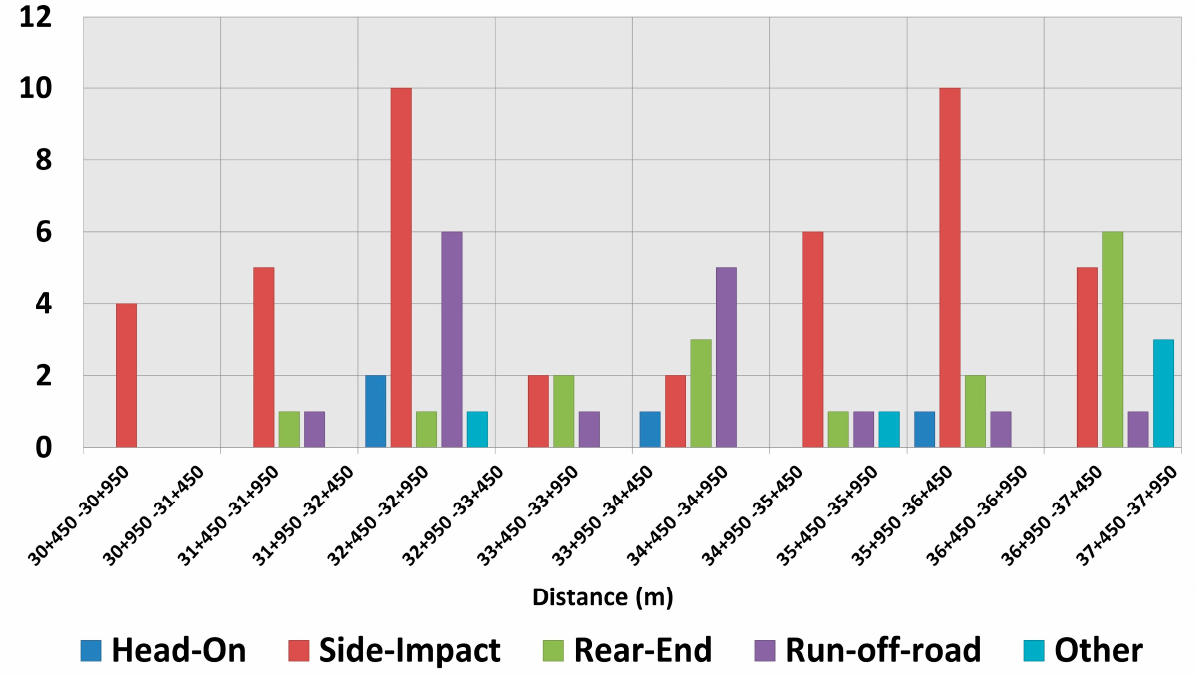
Figure 7. Accident types in the road sections.